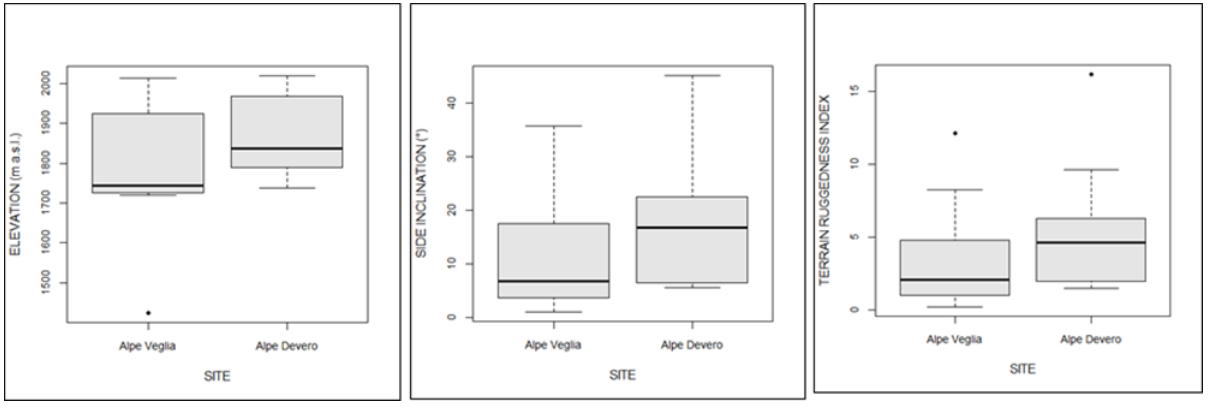
Figure 6 Comparison of the elevation (m above sea level), side inclination, and terrain ruggedness between host trees in Alpe Veglia and Alpe Devero.